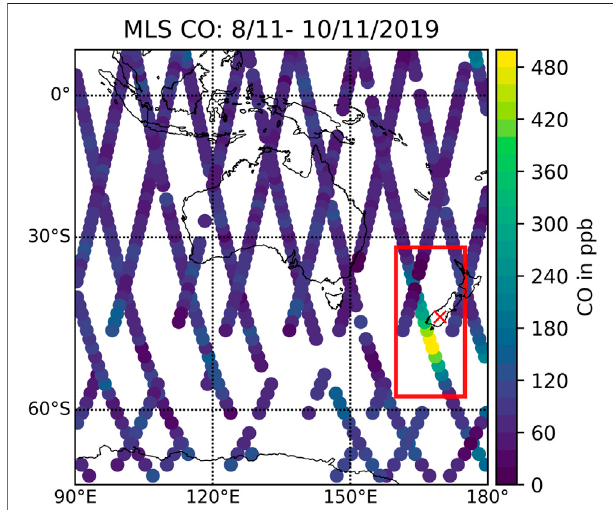
FIGURE 3 | MLS mean CO mixing ratios along the orbit, between the tropopause and 100 hPa below the tropopause ( ∼ 9 km) on a 2 ° latitude and 5 ° longitude grid, from November 6th to 8th (A) , 8th to 10th (B) and 10th to 12th 2019 (C) . The chosen grid roughly represents the horizontal resolution of MLS. The red box indicates an area that is later used for aerosol analysisin this study (160 – 175 ° E, 32 – 58 ° S). The red cross (within the red box) indicates the location of